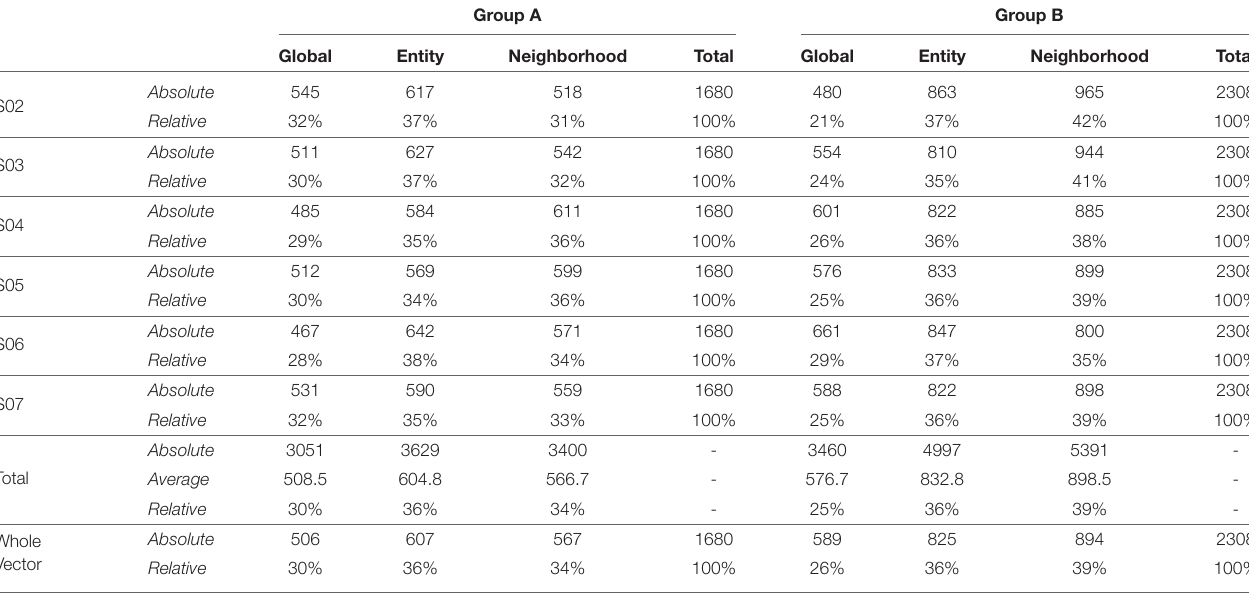
TABLE 3 | Number of invocations for the global and local models by ensemble predictors and whole vector predictor using UCB as a sampling strategy.